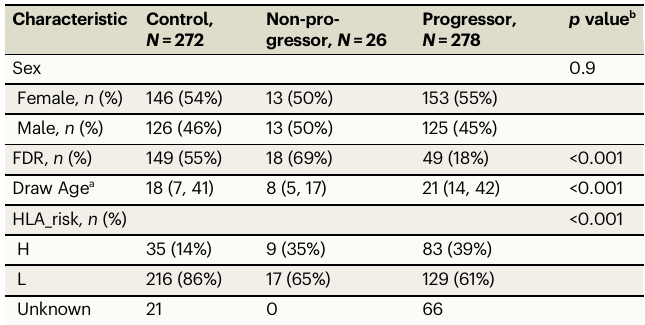
Table 1 | Clinical characteristics of participants of Phenome and Genome of Diabetes Autoimmunity (PAGODA) Study Characteristic Control, N